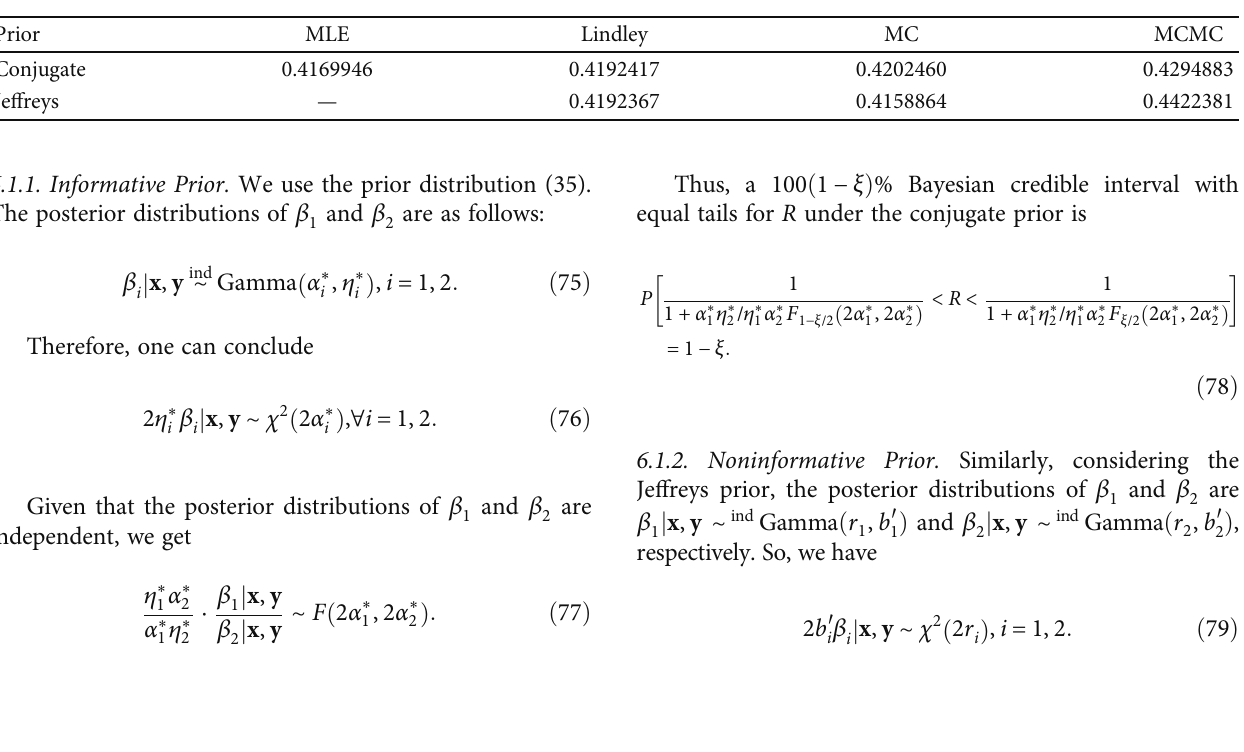
Table 8: Estimators of R for real data.